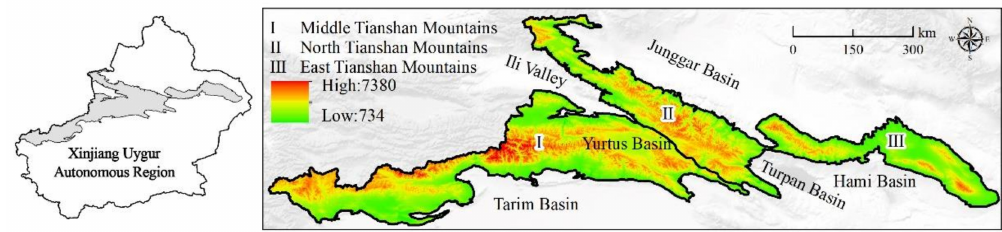
Figure 1. Location of study area (Map number: Xin S (2021)